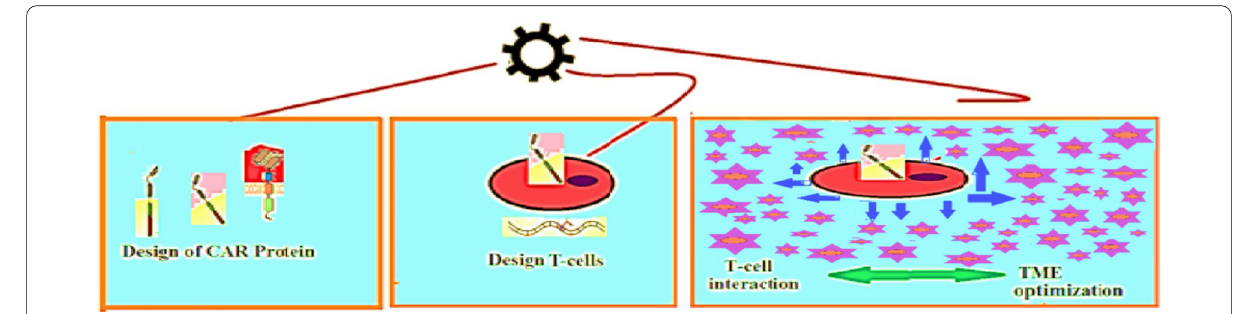
Fig. 1 Approaches for enhancing the activity of chimeric antigen receptor-T cells in solid